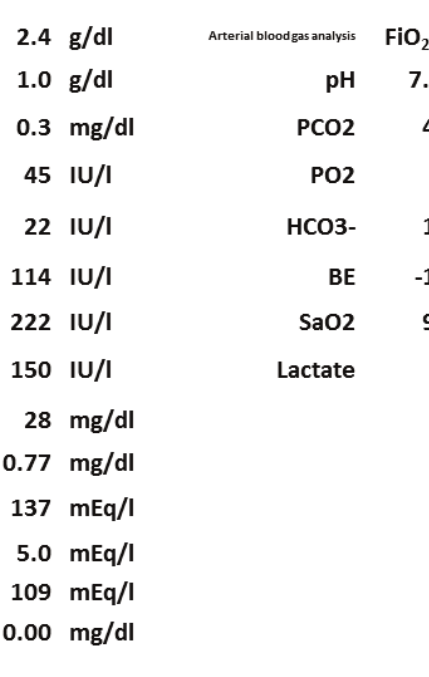
Table 1: Laboratory data on arrival at our